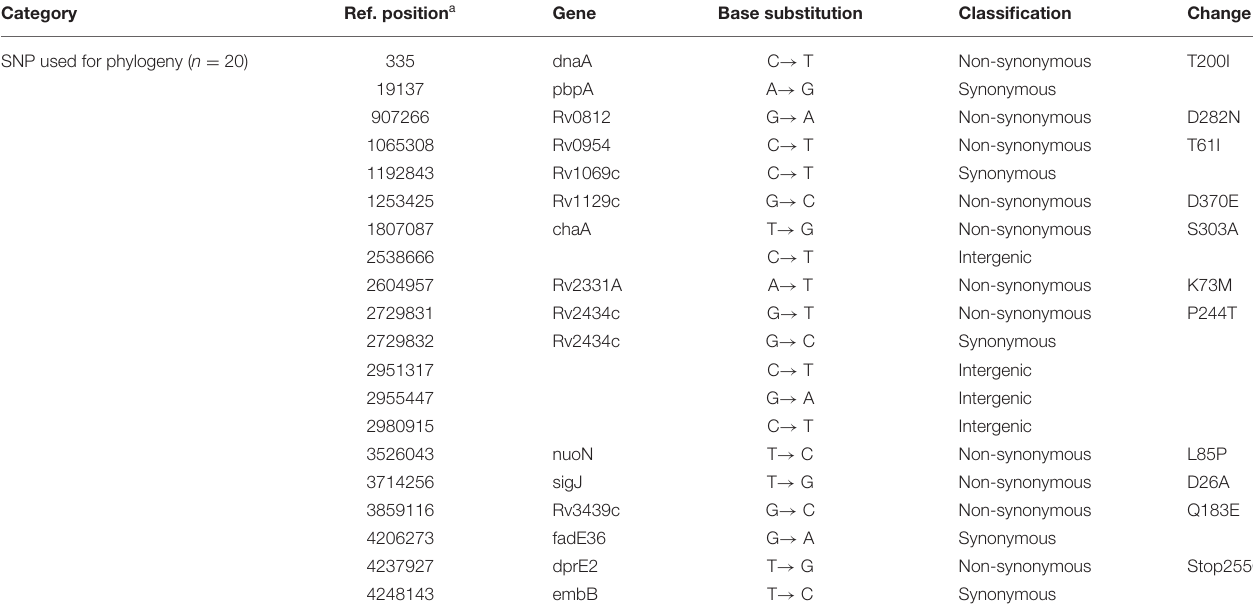
TABLE 4 | Single-nucleotide polymorphisms identified in the study (except case 5) by WGS. Category Ref. position a Gene Base substitution SNP used for phylogeny ( n =